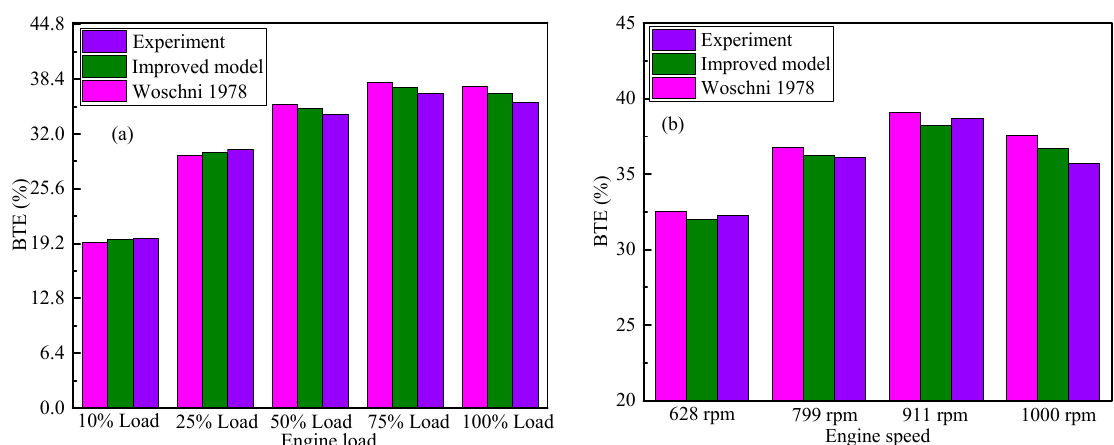
Figure 5. Comparison of brake thermal efficiency ( BTE ) under different load conditions.